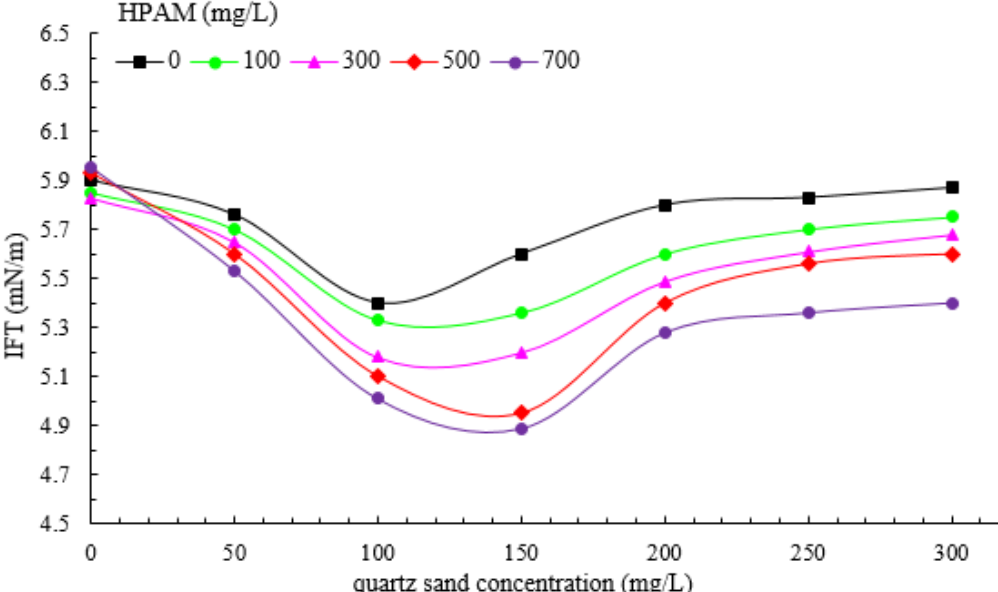
Figure 11. The synergetic effect of quartz sand particles and polymer on interfacial tension (alkali concentration 600 mg/L, surfactant concentration 200 mg/L)